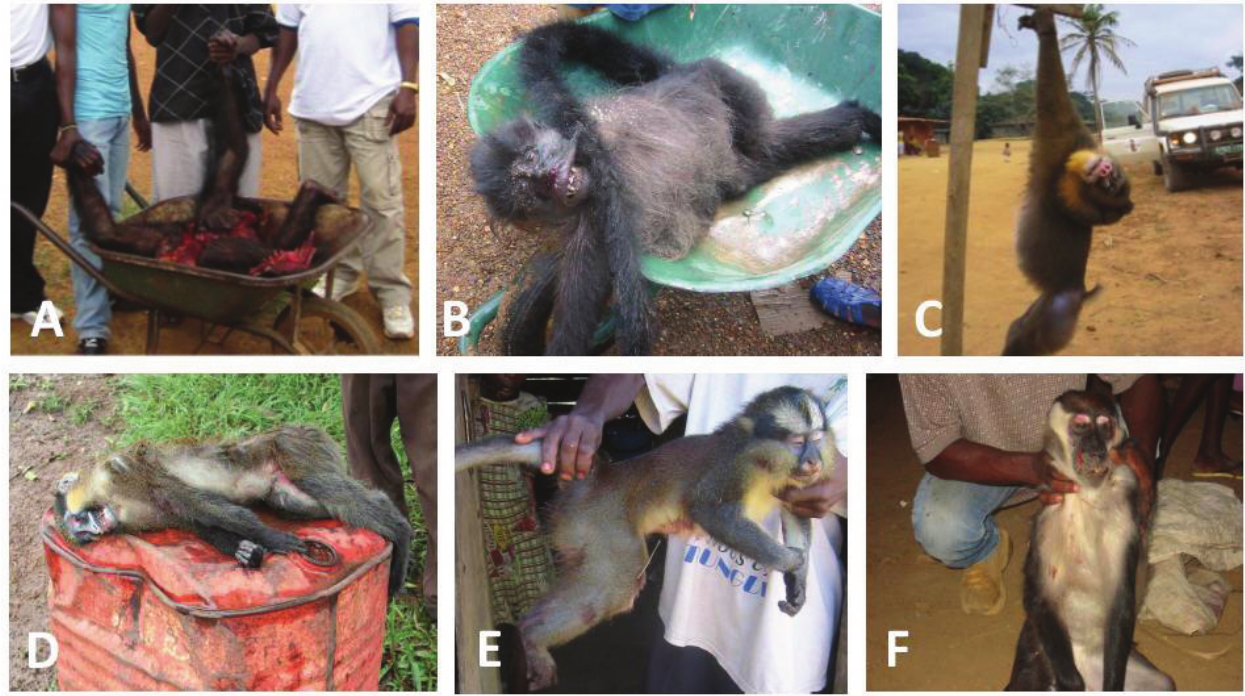
Figure 6. Non-human primates sold as bush meat in villages in rural Gabon. ( A ) Pan troglodytes troglodytes ; ( B ) Colobus satana ; ( C ) Mandrillus sphinx ; ( D ) Cercopithecus cephus ; ( E ) Cercopithecus neglectus and ( F ) Cercocebus torquatus .